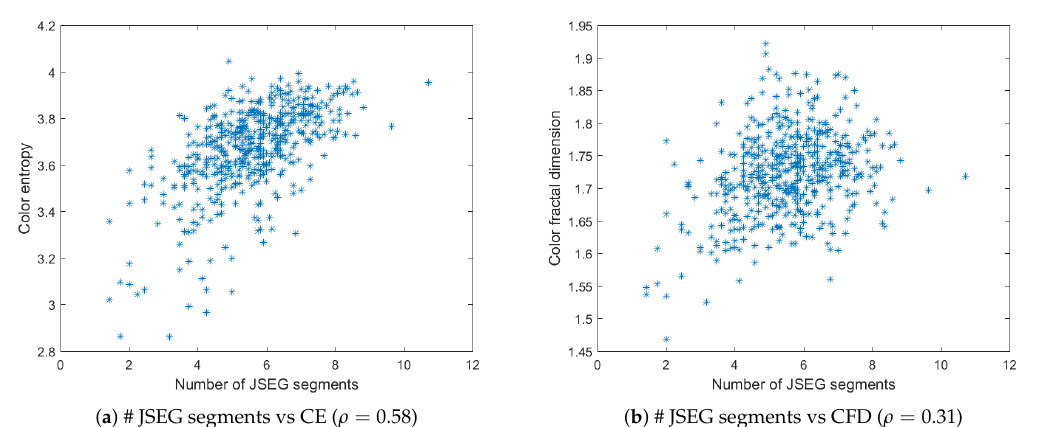
Figure 6. The number of JSEG segments versus color entropy ( a ) and color fractal dimension ( b ) for the BSDS500 data base. The corresponding Pearson correlation coefficient is given in brackets for each